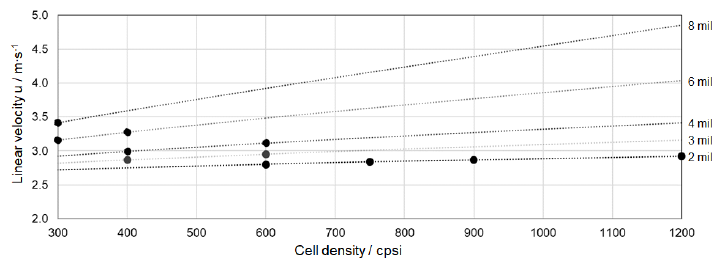
Figure 8. Linear gas velocity at a flow rate of 100 kg/h and 523 K.